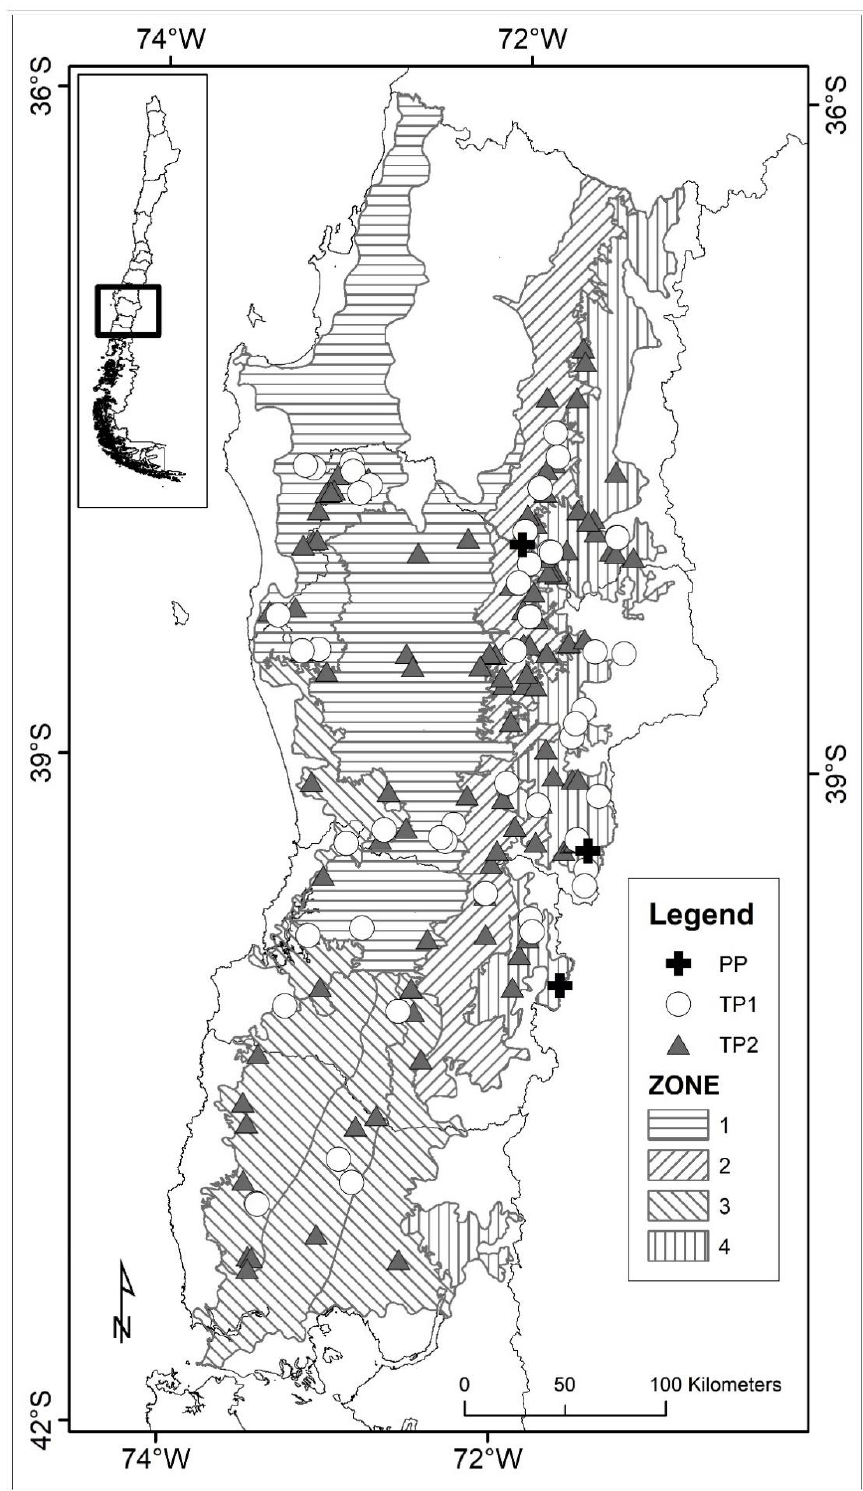
Figure 1. Map of the location of plots within the natural distribution of forest type RORACO (shaded area) for the permanent plots (PP) and temporary plots (TP1 and TP2). Growth zones (1 – 4) are also identified.